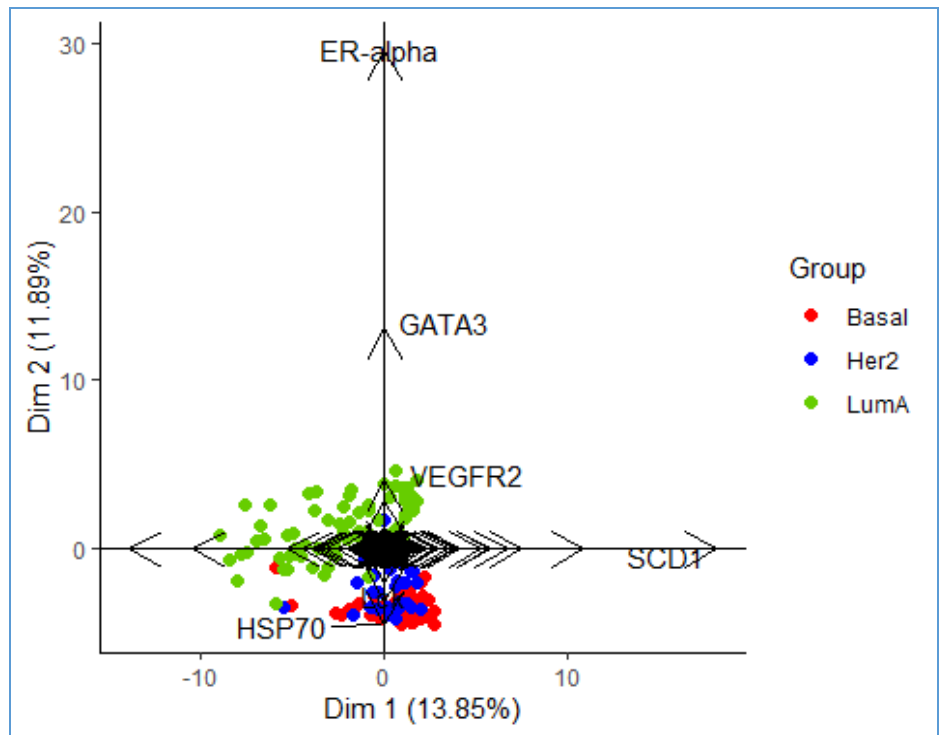
Figure 4. Disjoint biplot